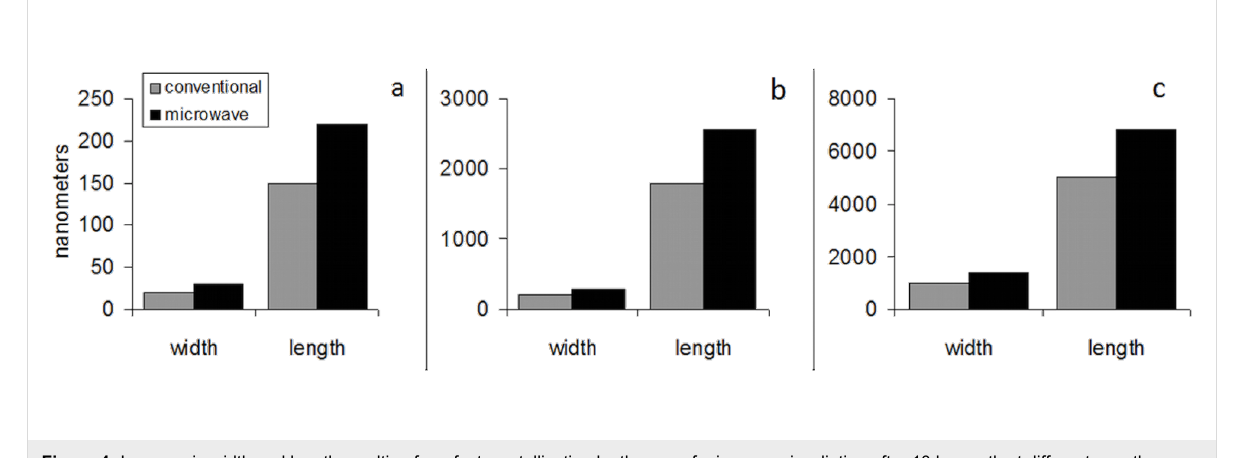
(Figure 6: inset) show higher absorption in the rapidly